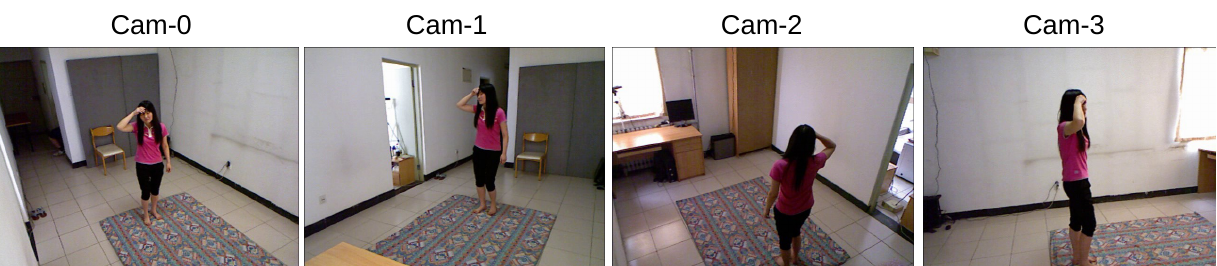
Figure 3. An example of all the camera views in the ACT42